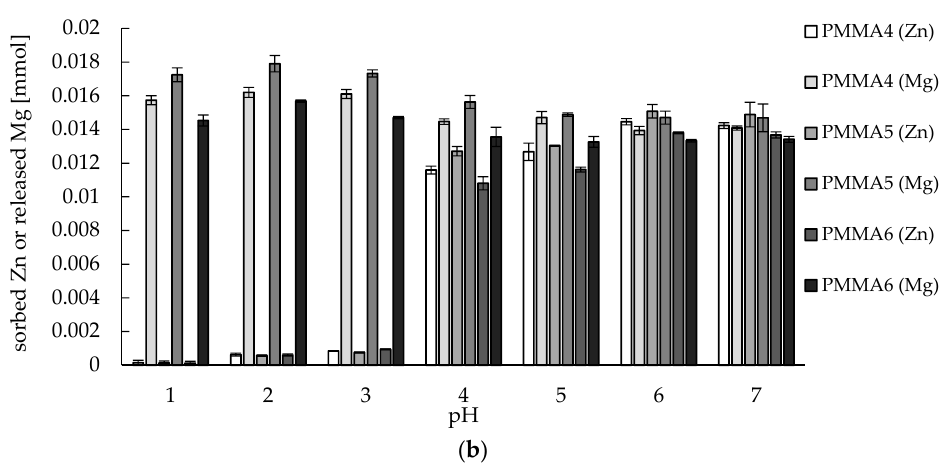
Figure 4. Comparison of amount of sorbed zinc(II) and amount of released ( a ) calcium(II), ( b ) magnesium(II) ions during sorption studies at various pH conditions. Mass of sorbent 0.01 g, initial concentration of metal: c = 30 mg/L, volume of solution: 0.05 L, pH = 6, temperature 22 ± 1 °C.